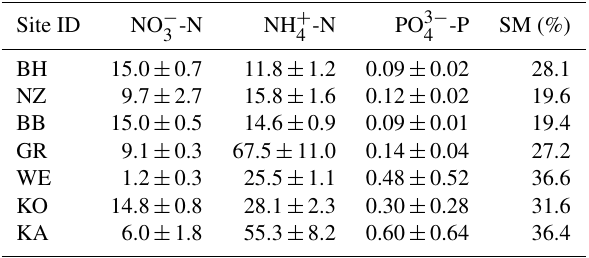
Table 2. Initial nutrient concentrations (µgkg − 1 DM; mean ± SD) and gravimetric soil moisture at the start of the FTC treatment. Site IDs correspond to Table